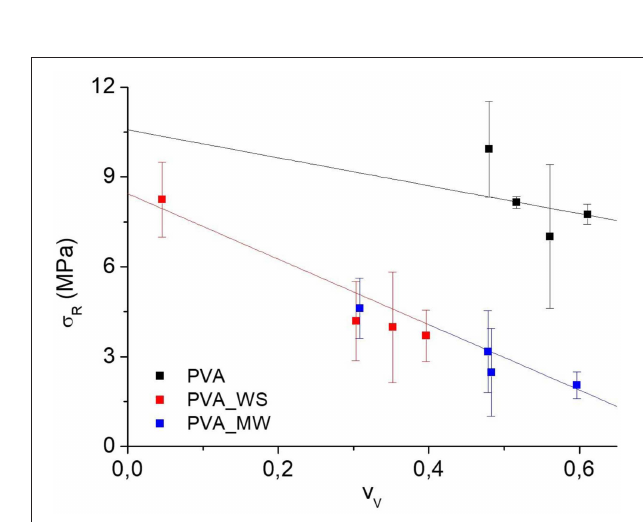
FIGURE 9 | Flexural modulus as a function of void fraction.